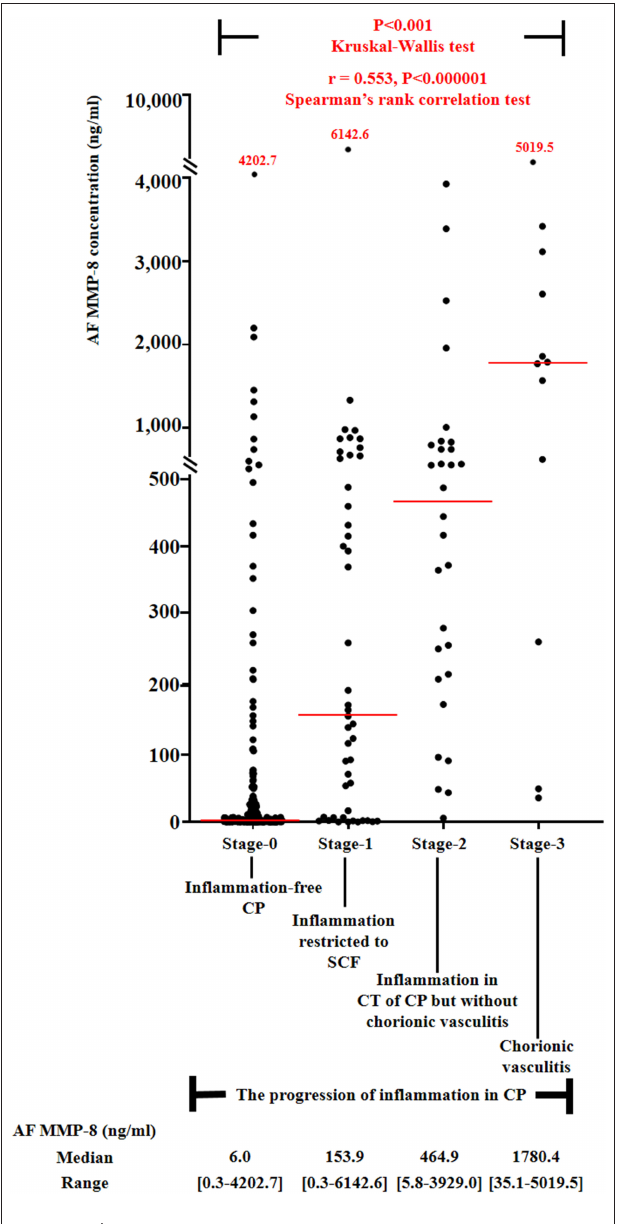
FIGURE 1 | Amniotic fluid (AF) MMP-8 concentrations according to the progression of inflammation within chorionic plate (CP) [stage-0, inflammation-free CP vs. stage-1, inflammation restricted to subchorionic fibrin (SCF) vs. stage-2, inflammation in the connective tissue (CT) of CP without chorionic vasculitis vs. stage-3, chorionic vasculitis; median, range, 6.0ng/ml (0.3–4202.7ng/ml) vs. 153.9ng/ml (0.3–6142.6ng/ml) vs. 464.9ng/ml (5.8–3929.0ng/ml) vs. 1780.4ng/ml (35.1–5019.5ng/ml)] among preterm gestations. Each P -value is shown in the graph. AF MMP-8 concentration results were available in 299 patients, and those were not examined in 10 patients due to the limited amount of remaining